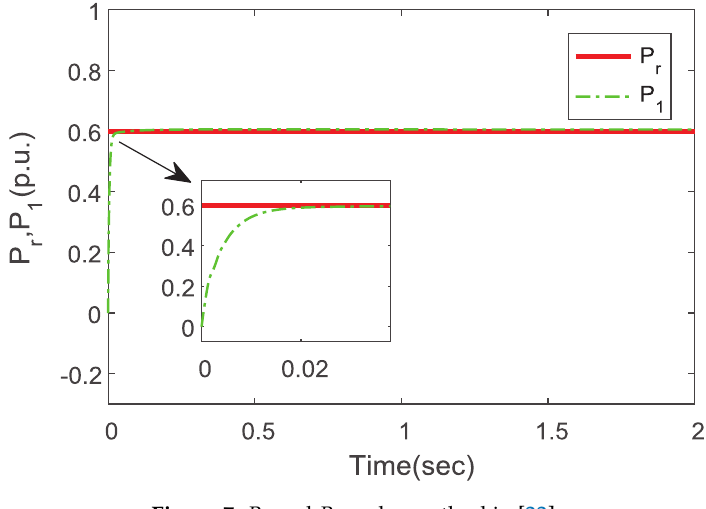
Figure 7. P 1 and P r under method in [22].